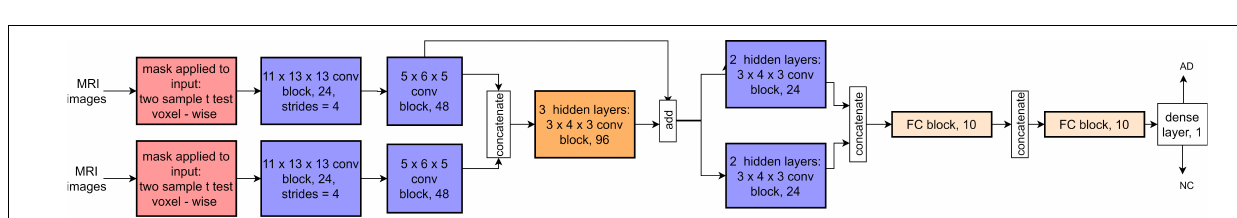
FIGURE 1 | Overview of the learning procedure: (1) Spatial normalization of MR structural images and group analysis on training data. (2) t -Masking of input images. (3) Training and classification of 3D CNN.